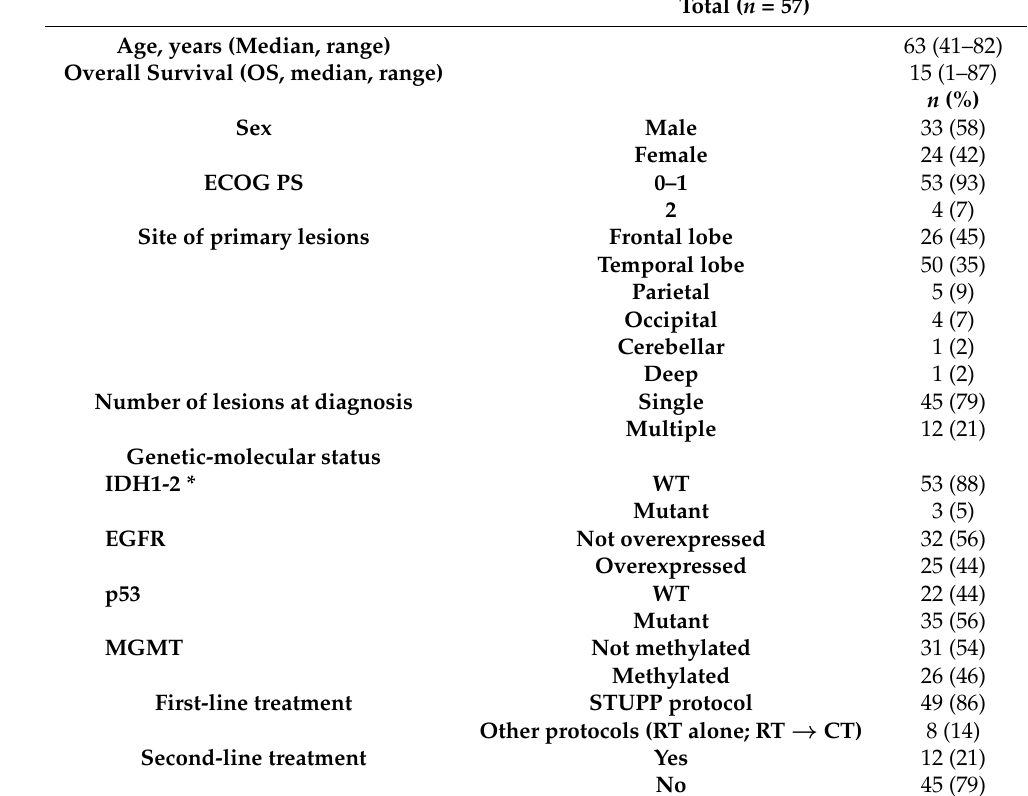
Table 1. Patient